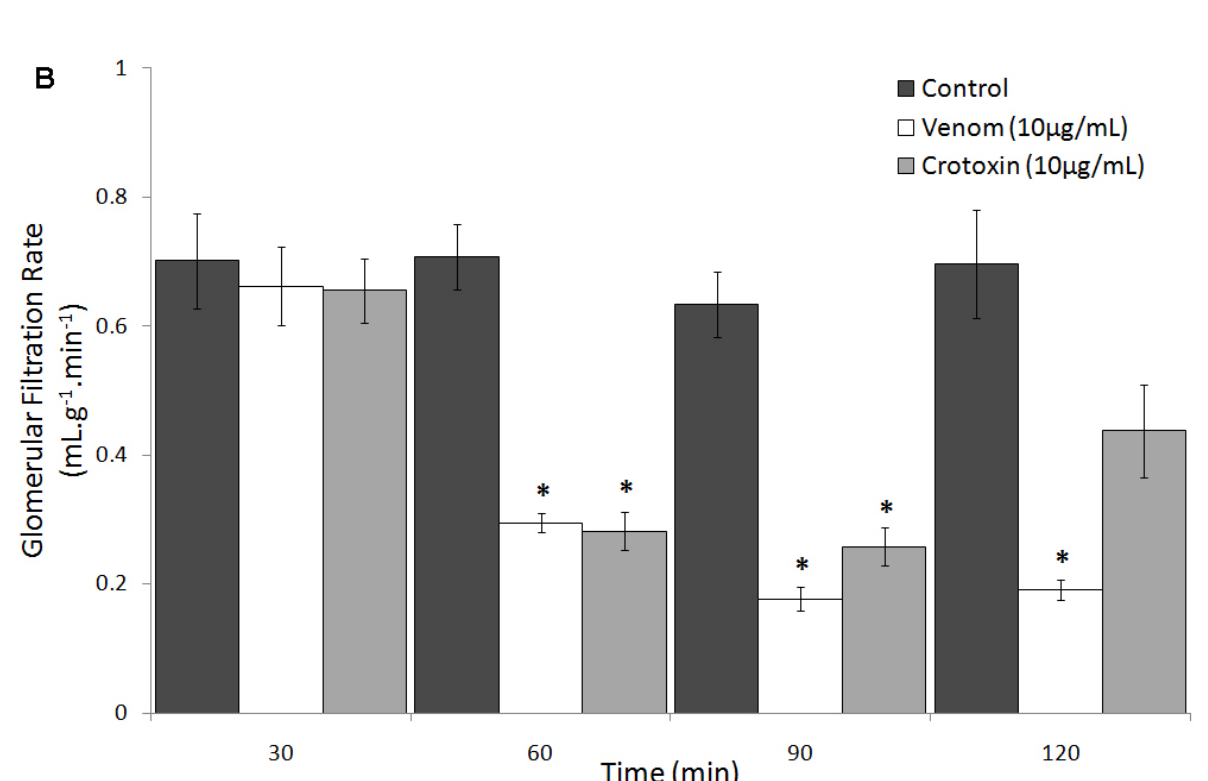
Figure 4. Effects of C. d. cumanensis venom (10 µg/mL) and crotoxin (10 µg/mL) on ( A ) urinary flow (UF) and ( B ) glomerular filtration rate (GFR).The results are expressed as mean ± SEM, ANOVA, Bonferroni post-test, * p < 0.05, compared to the corresponding control